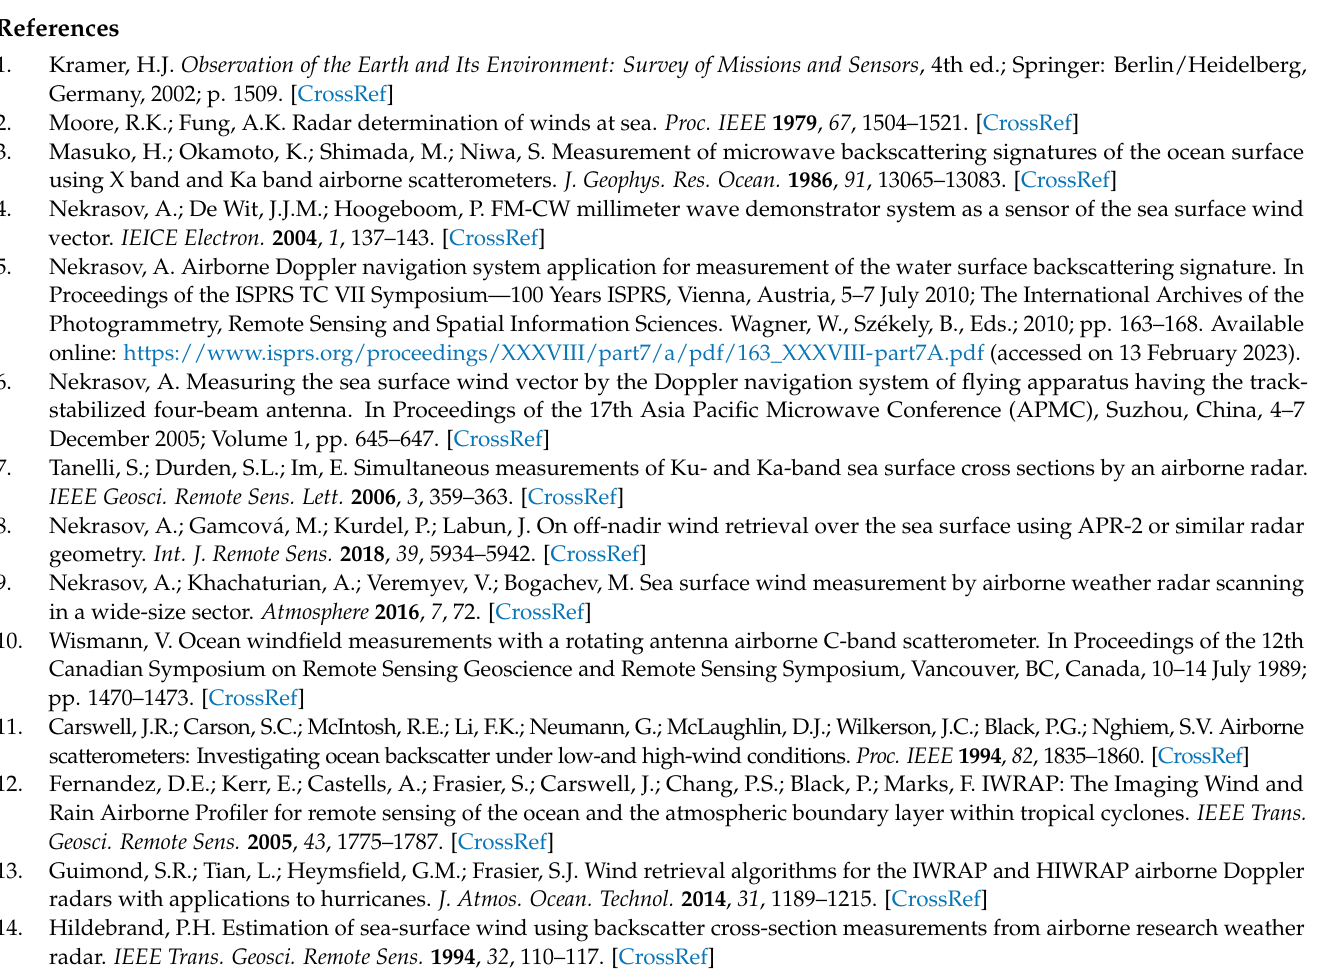
Figure A25. Semicircular wind retrieval results at the (30°, 45°, 60°) incidence angle combination.